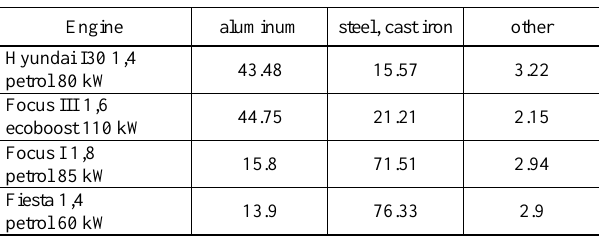
Fig. 3. Percentages of CO 2